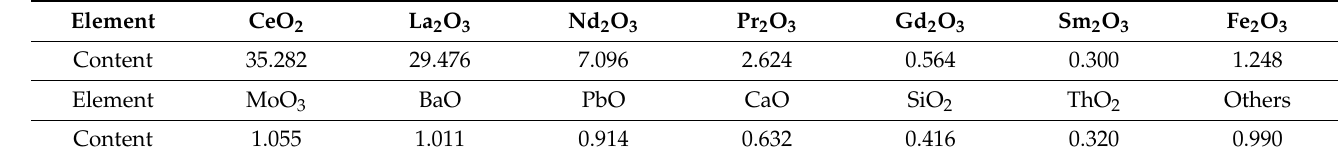
Table 1. Chemical composition of bastnaesite powder samples (weight %).